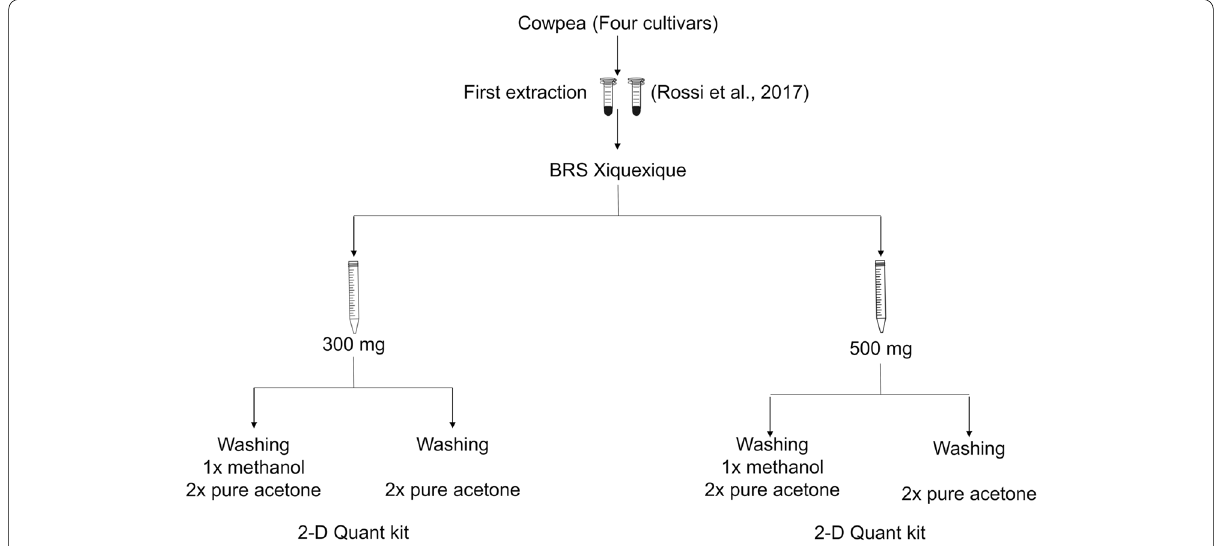
Fig. 1 Summary of the protein extraction